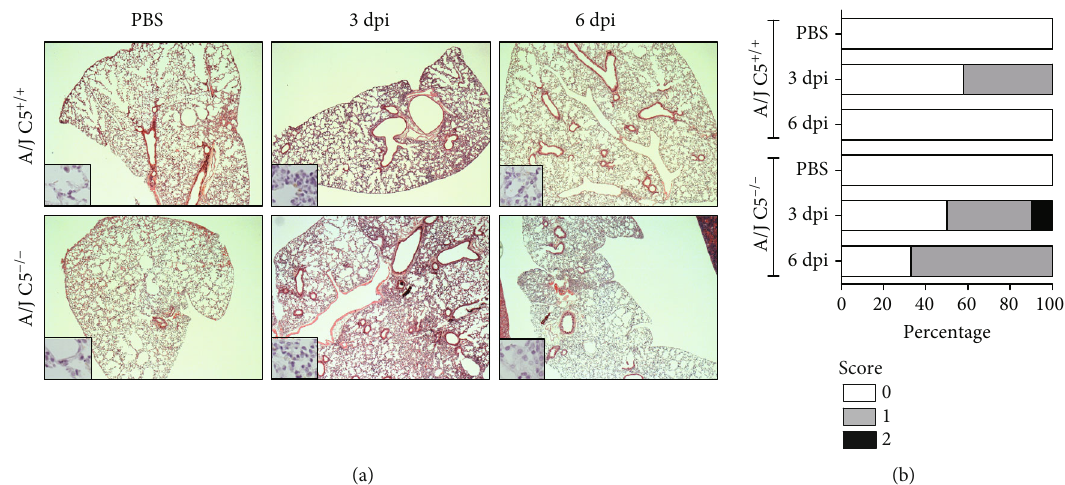
Figure 2: Lung histopathological analysis in LPF-infected A/J mice. Mice were inoculated i/p with 1 : 5 × 10 8 LPF or only PBS and then euthanized on the third or the sixth days postinfection ( n ≥ 4 ). (a) Lung sections (3 – 5 μ m) were stained with HE and evaluated at 200x magni fi cation. The inserts present the immunohistochemical analysis of the lung from LPF-infected mice evaluated at 400x magni fi cation. (b) Total scores of lung lesions. A/J -/- : C5-de fi cient mice, PBS ( n = 5 ), 3dpi ( n = 12 ), 6dpi ( n = 9 ); A/J C5 +/+ : congenic C5-su ffi cient mice PBS ( n = 4 ), 3dpi ( n = 10 ), 6dpi ( n = 9 ).dpi: days postinfection.